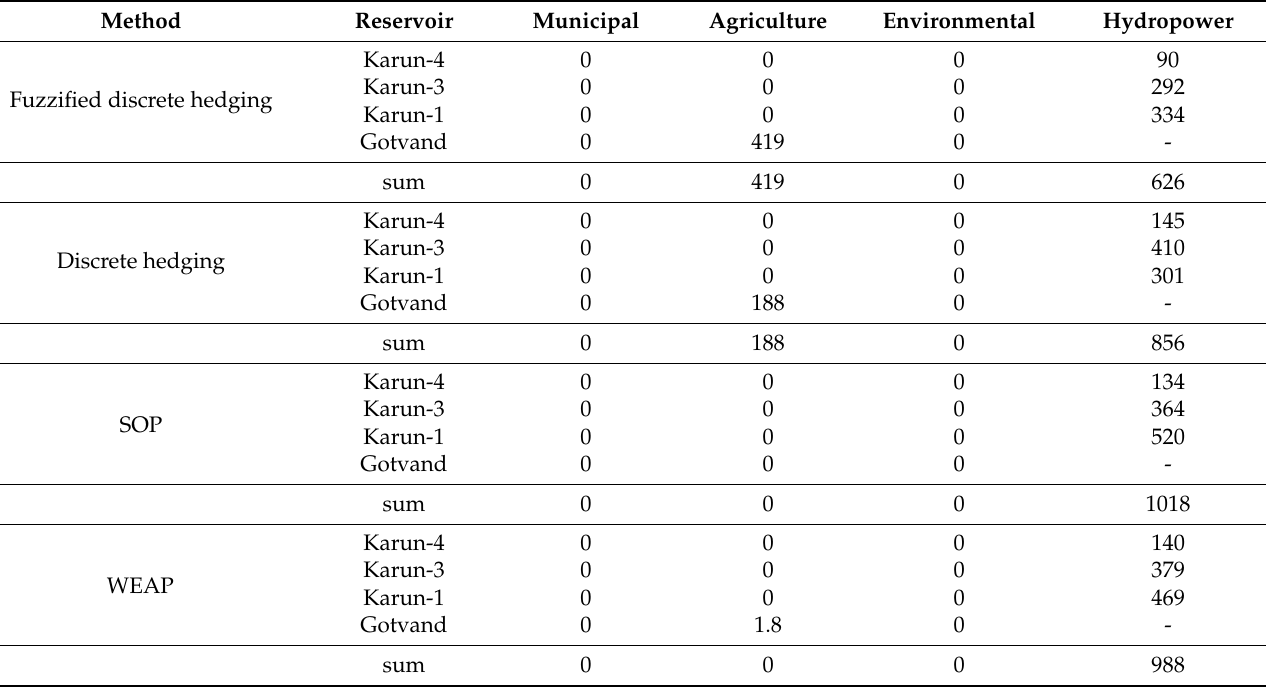
Table 6. Maximum monthly deficiency during the test period (MCM).